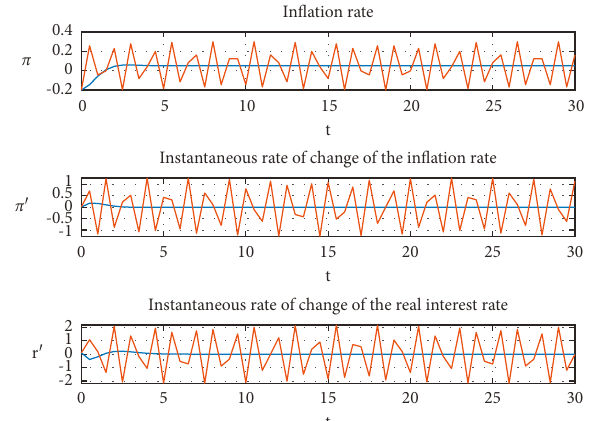
Figure 20: Time paths of the interest rate and instantaneous rates of change of inflation and the interest rate (For I 2 and with β 19 β 0 (cid:31) > e y ), inflation, expected inflation, and the instantaneous ( Y (cid:31) rates of change of the interest rate and inflation. In this last